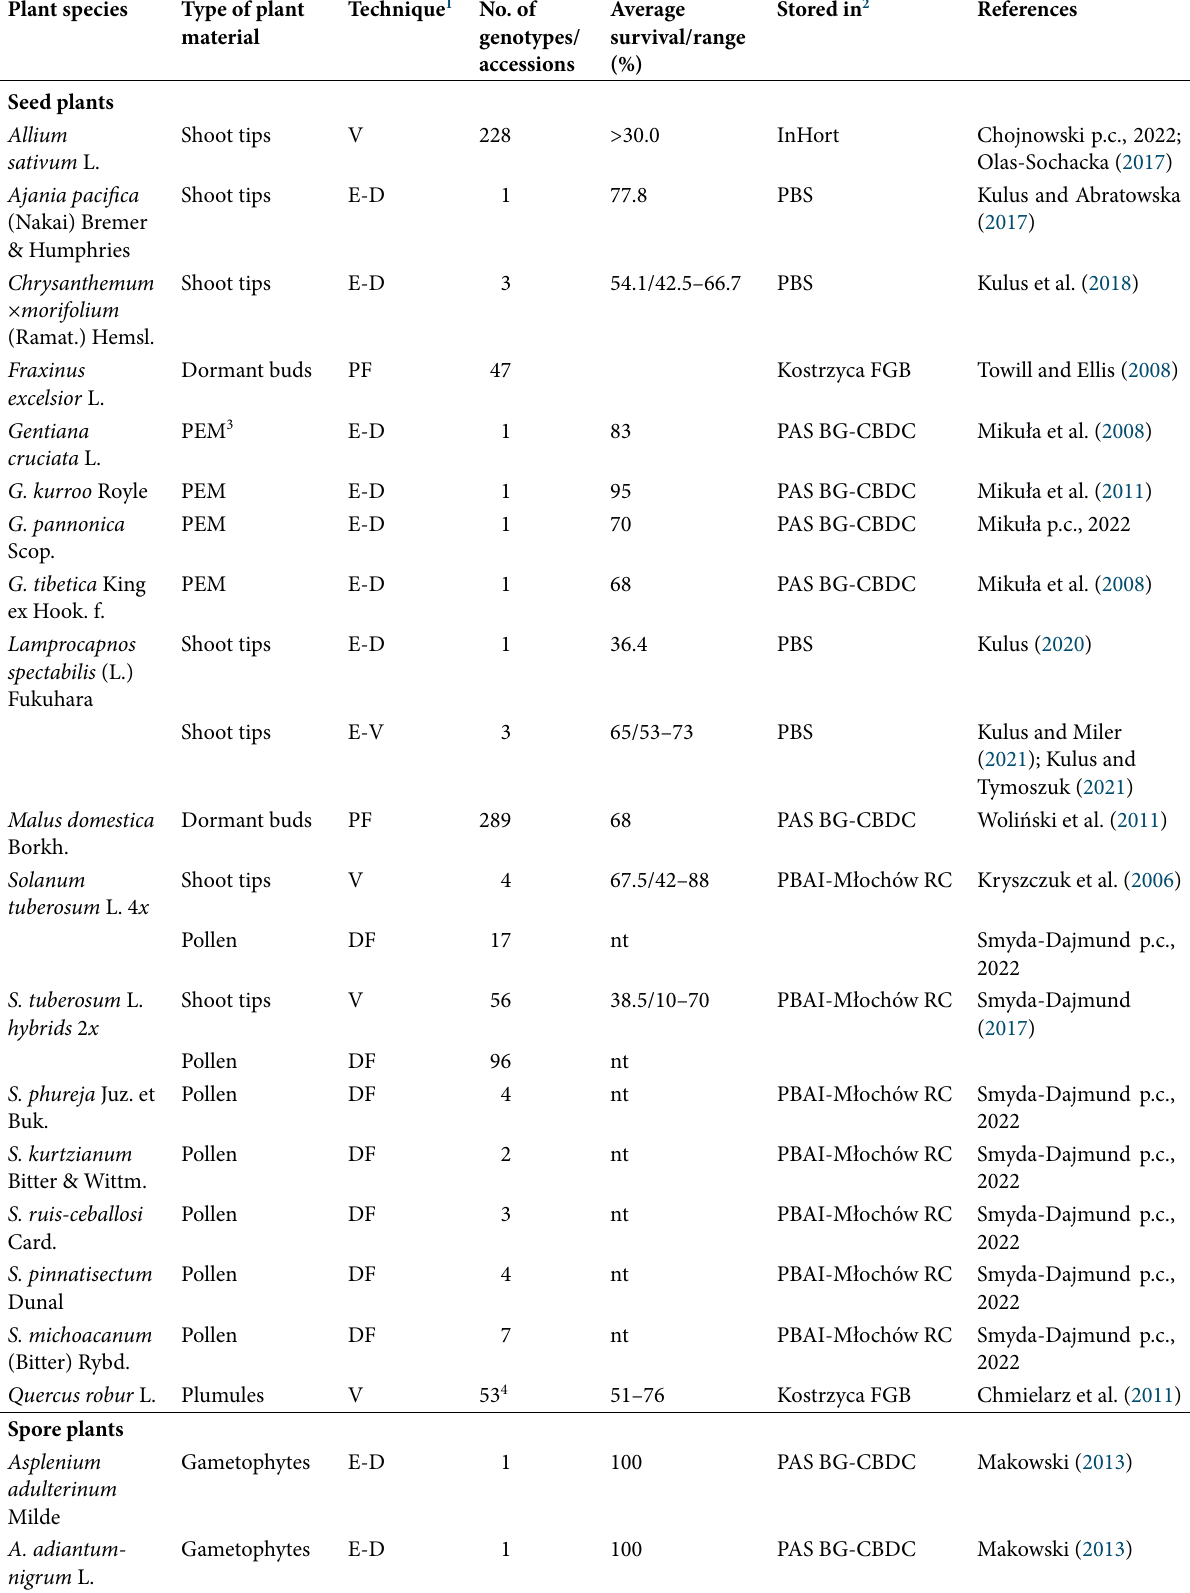
Table 1 Cryopreservation procedures of plant material (excluding seeds) developed in Poland for plant species accessions stored for long term in liquid nitrogen or its